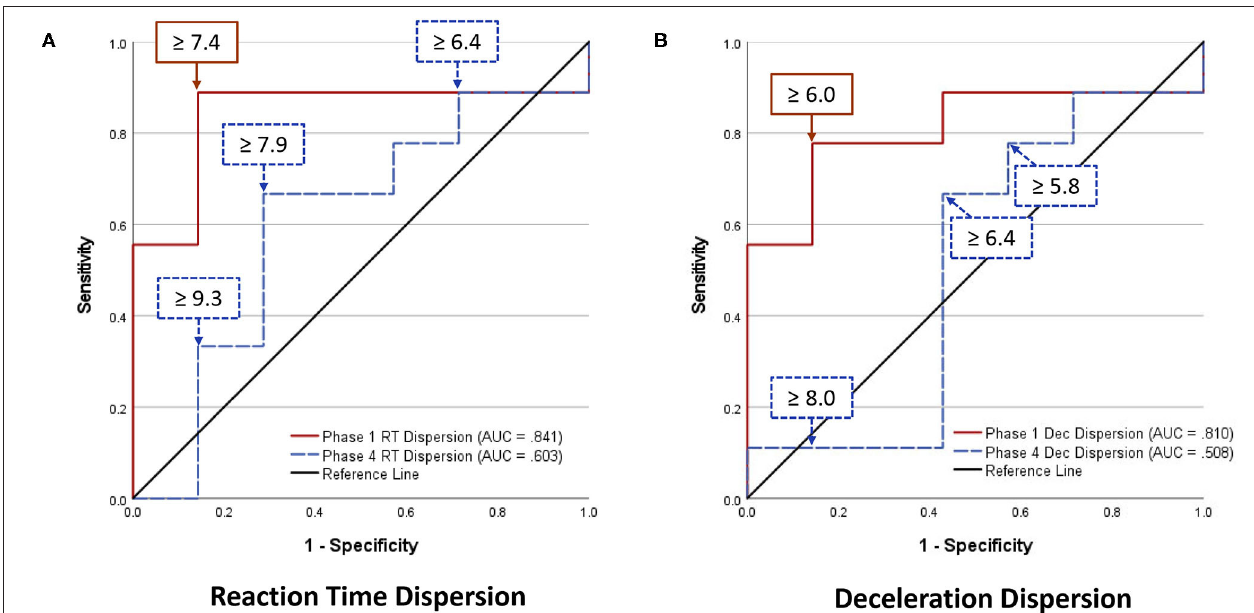
FIGURE 2 | Receiver operating characteristic curves identifying History of Sport-Related Concussion cases in early phase (red solid line; sessions 1–3) and late phase (blue dashed line; sessions 10–12) of 12-session whole-body reactive agility training program on the basis of Dispersion (standard deviation of t-scores for 2 movement directions and 4 task modes): (A) Reaction Time Dispersion, (B) Deceleration Dispersion.